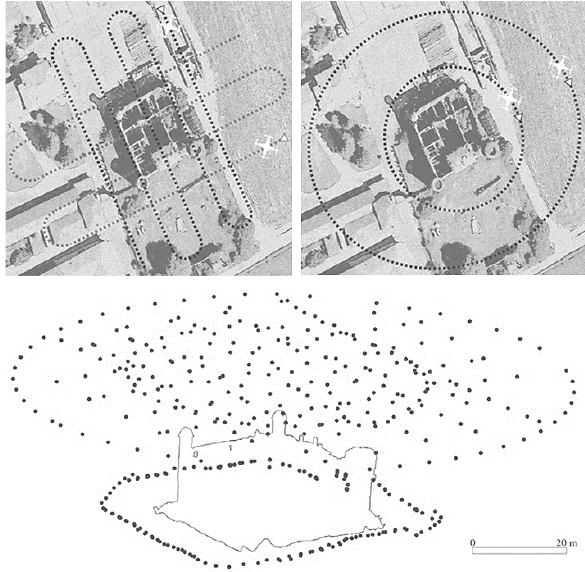
Figure 2 . From the top: drones trajectories; position of cameras used for architectural component’s